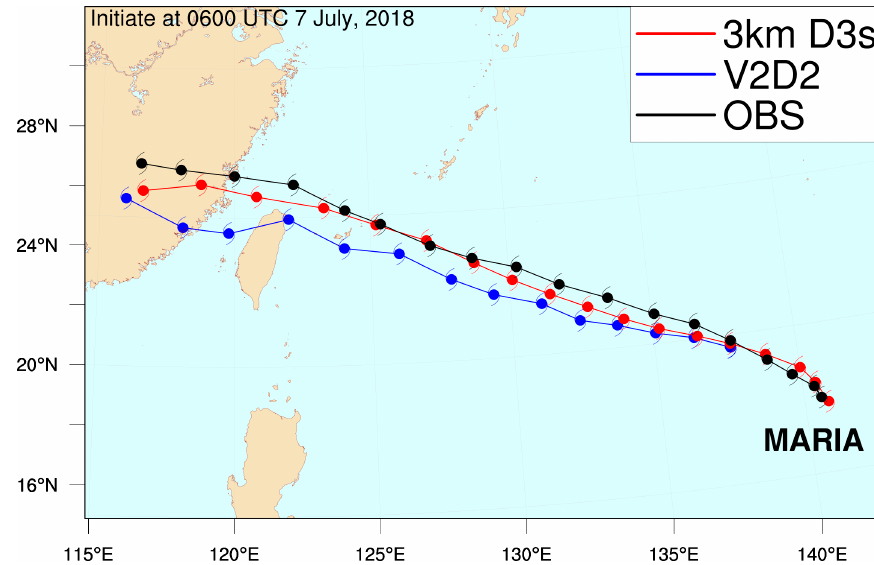
Figure 14. Tracks of Maria in every 6 h from the CWB best track (black line), the blue and red line represented for the forecast track from the original TWRF operation V2D2 (blue line with the blue box in Figure 13) and the 3-km D3s strategy decided nested domain (red line with the red box in Figure 13) for a 102-h forecast starting from 0600 UTC 7 July 2018.